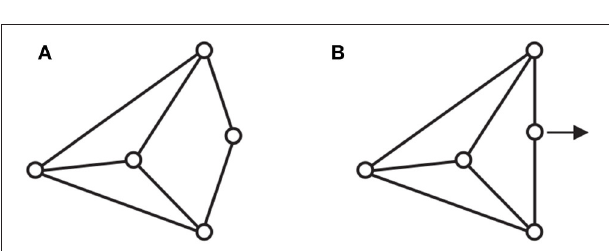
FIGURE 4 | An infinitesimally rigid framework (A) and a rigid framework which is not infinitesimally rigid (b). The horizontal nodal velocity vector shown in (B) , when all the other nodes are fixed, cause null changes in length but it is not a rigid